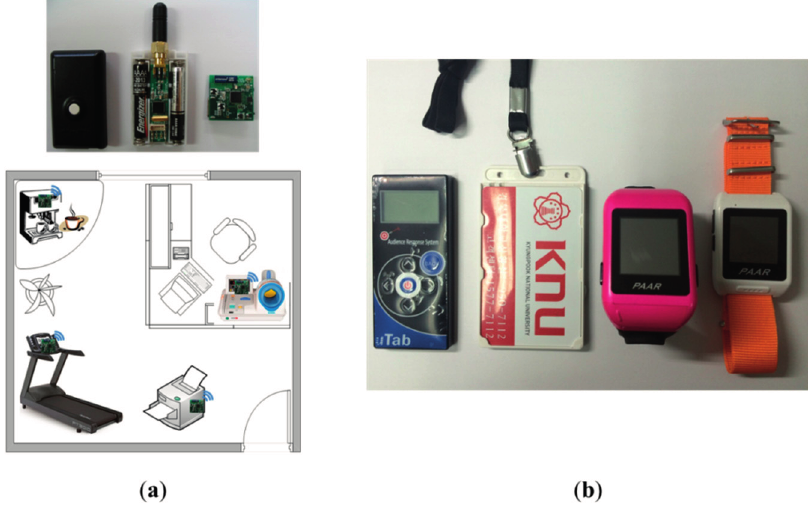
Figure 19. Service resource devices and mobile devices owned by users. ( a ) Service resource devices with communication module; ( b ) Mobile